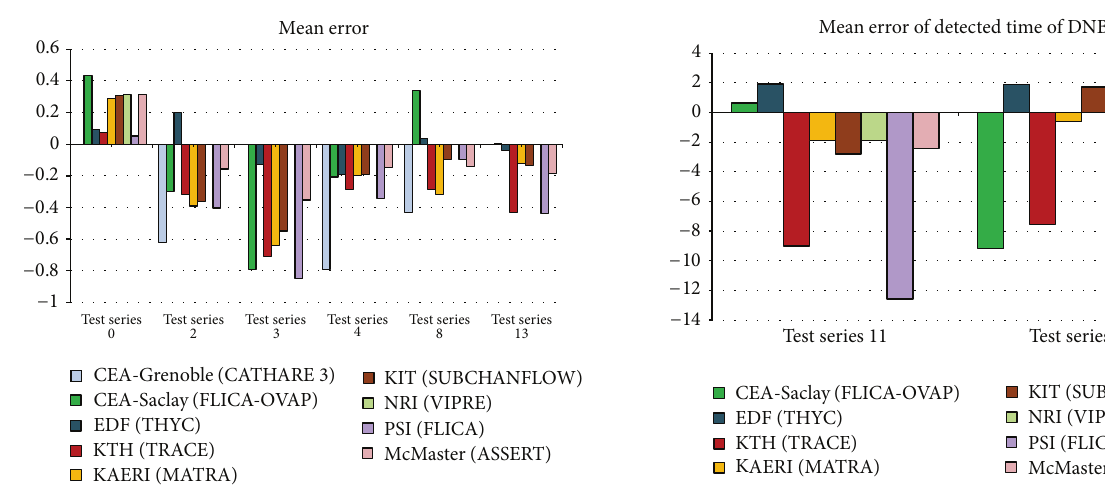
Figure 31: Mean error of predicted DNB power.